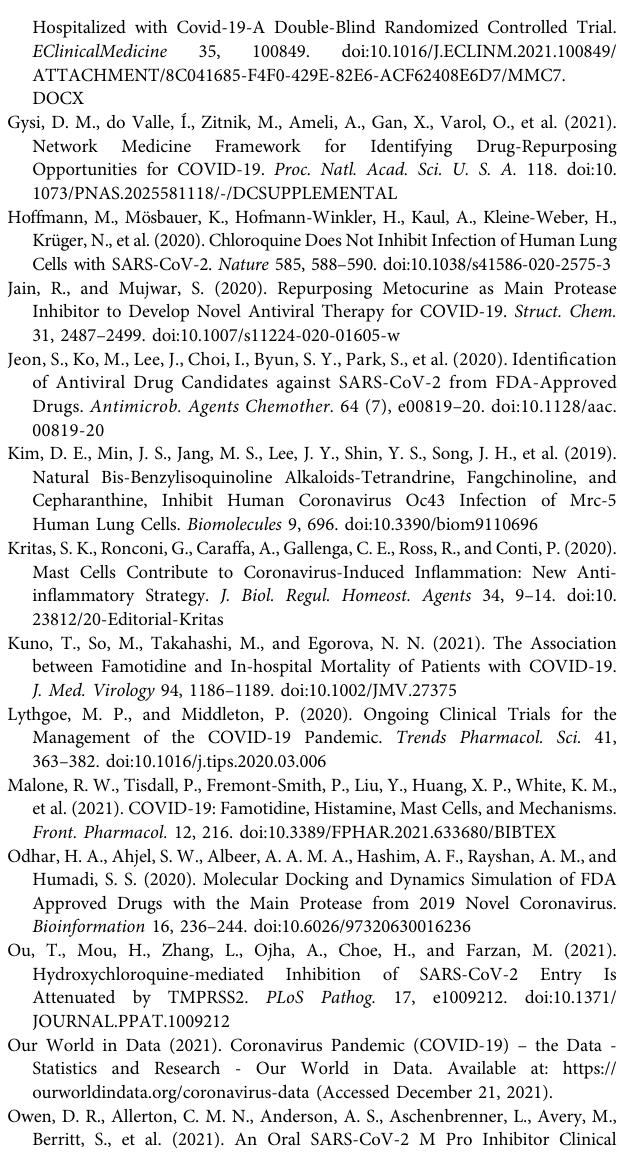
culture supernatant and was quanti fi ed by droplet digital PCR (A) or qPCR (B – E) analysis. Graphs show mean viral genome counts ±SEM from 5 (A) or 3 (B-E) biological replicates and 2 (A) or 3 (B-E) technical repeats. Supplementary Figure S3 | Prevention of SARS-CoV-2 induced cytopathic effect by azelastine. VeroE6 cells were infected withSARS-CoV-2 simultaneously with the addition of 0.4 to 25 µM of azelastine and continued to be cultured without the virus in the presence of the respective concentrations of the drugs. Cytopathic effect was assessed by light fi eld microscopic examination of cultures 48 hours post-infection. (A) uninfected (negative) control, (B) virus infected (positive) control, (C) virus + 3.125 µM azelastine, (D) virus + 6.25 µM azelastine, (E) virus + 12.5 µM azelastine, (F) virus+25 µMazelastine. (G) Scoringsystemandsummaryofcytopathiceffectin the presence of azelastine (results of two independent experiments). Supplementary Figure S4 | Azelastine blocks viral replication in SARS-CoV-2 infected reconstituted human nasal tissue. MucilAir TM human nasal tissue was infected with SARS-CoV-2 and subsequently treated with fi ve-fold diluted (i.e. fi nal concentration of 0.02% azelastine) nasal spray solution for 20 min in every 24 hforthreedays.Lowresolutionmicroscopicimagesofculturesafter48and72 h of